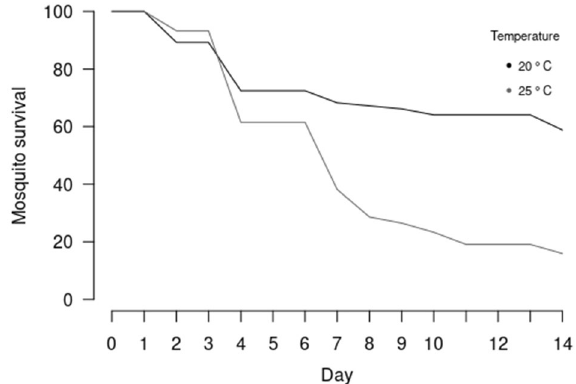
Figure 1. Survival of Cx. pipiens following a blood-meal containing JEV over the fourteen-day experimental timeframe. Mortality was two-fold higher in the 25 °C cohort when compared with the 20 °C cohort ( χ 2 = 52.68, P < 0.001).